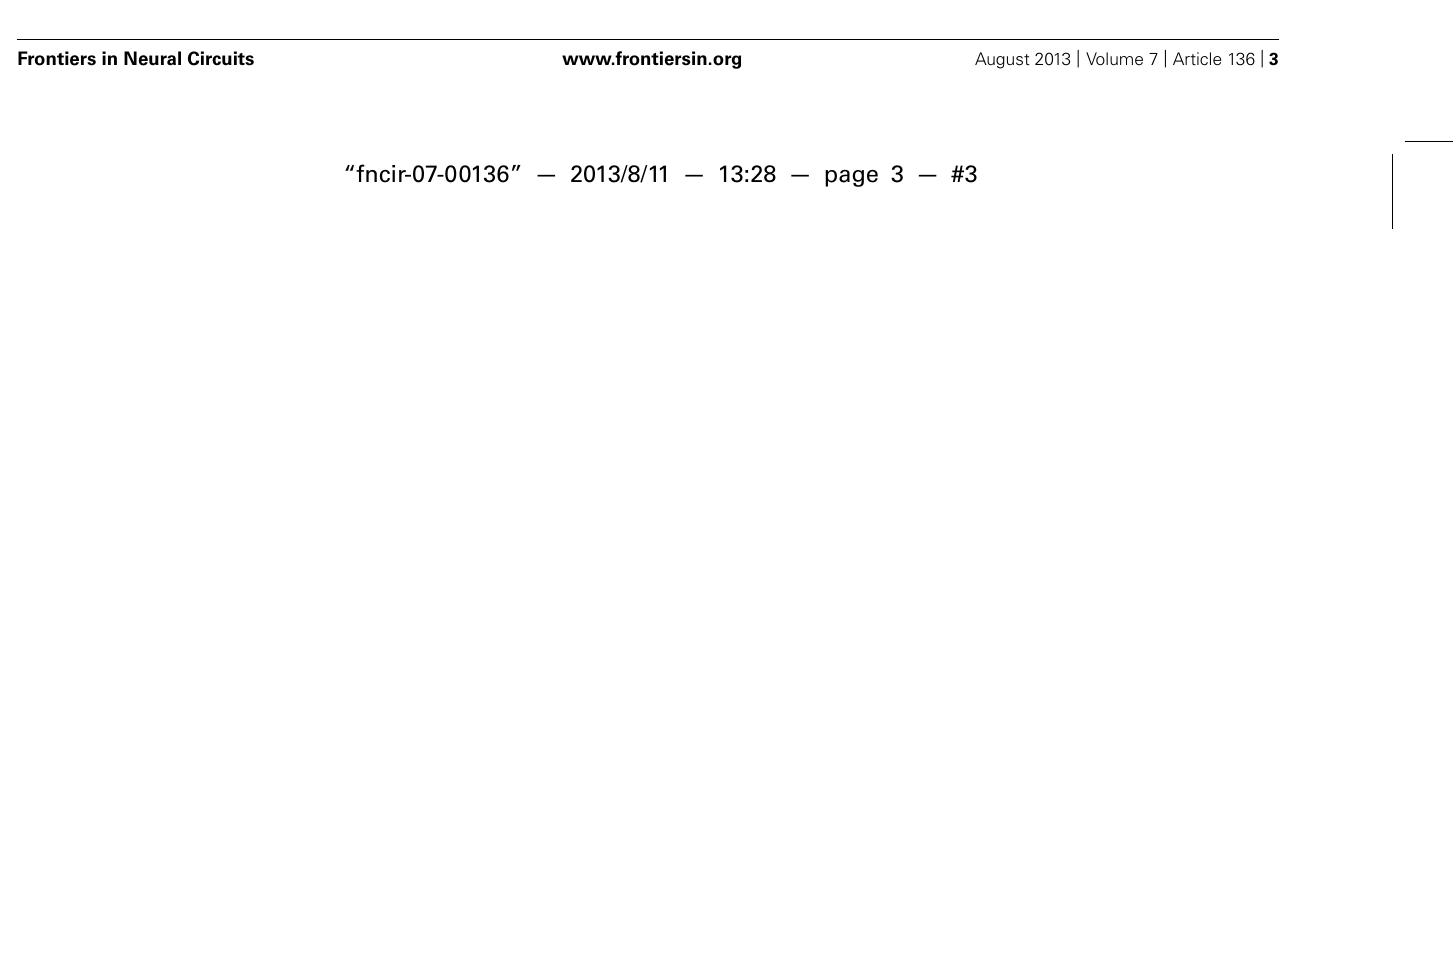
FIGURE 1 | In the immature hippocampus, ambient GABA depolarizes targeted cells and contributes to generate network-driven GDPs. (A) Late in embryonic, early in postnatal life, prior to synapses formation, GABA released from growth cones diffuses in the extracellular space (light blue), binds to GABA A receptors located on the membrane of a neighboring cell (gray) and depolarizes the membrane through an outwardly directed flux of chloride.This results from the peculiar balance between the cation-chloride importer NKCC1 (large circle in green) and the poorly expressed cation-chloride extruder KCC2 (small circle in green), leading to accumulation of chloride inside the cell [Cl − ] i .Tonic GABA current can be unveiled by applying picrotoxin (PTX, 100 μ M; bar) as illustrated in the inset on the right. (B) After birth, during the first postnatal week, chemical GABAergic and glutamatergic synapses start appearing. GABA released by exocytosis from presynaptic vesicles (dark blue) acts on postsynaptic GABA A receptors located in face to presynaptic release sites and generate synaptic currents (inset on left). Once released GABA spills out (light blue) to activate extrasynaptic GABA A receptors. At this stage, glutamatergic synapses are also formed (yellow).The synergistic action of GABA and glutamate, both depolarizing and excitatory is crucial for GDPs generation. At this developmental stage, both phasic and tonic GABA are depolarizing since the cation-chloride extruder KCC2 is still poorly expressed on the membrane surface (small circle in green). (C) In adulthood, GABA acting on both synaptic and extrasynaptic GABA A receptors hyperpolarizes the membrane.This occurs because, due to the developmental up-regulation of the cation-chloride